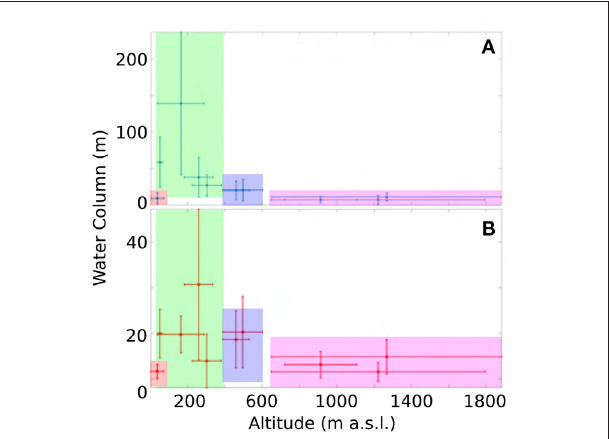
FIGURE 13 | Mean values of the water column distribution for the ten sectors of hydrogeological continuity. (A) Pore water columns. (B) Available water columns. The sectors are grouped in shaded boxes accordingly to the color boxes of Figure 4 . The horizontal error bars correspond to the full topographic span of each sector and the vertical error bars correspond to the total variability of the water column within each sector, which is a combination of its spatial standard deviation and its average uncertainty (Equation